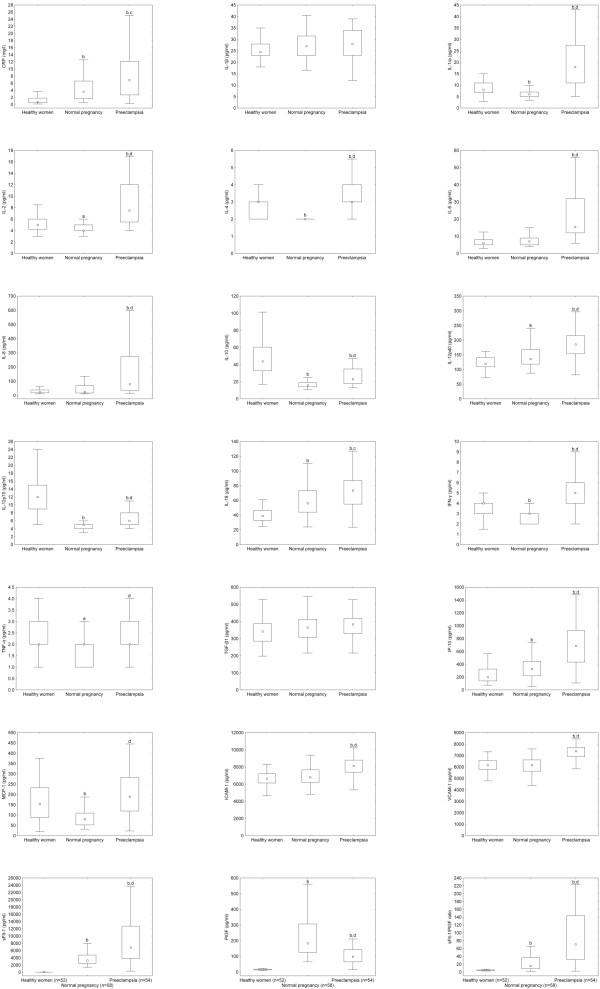
Serum levels of C-reactive protein, cytokines, chemokines, adhesion molecules and angiogenic factors in healthy non-pregnant and pregnant women and preeclamptic patients. Middle point: median; Box: interquartile range (25-75 percentile); Whisker: range (excluding outliers). CRP: C-reactive protein; IL: interleukin; IL-1ra: IL-1 receptor antagonist; IFN: interferon; TNF: tumor necrosis factor; TGF: transforming growth factor; IP: interferon-γ-inducible protein; MCP: monocyte chemotactic protein; ICAM: intercellular adhesion molecule; VCAM: vascular cell adhesion molecule; sFlt: soluble fms-like tyrosine kinase; PlGF: placental growth factor. a p < 0.05 versus healthy non-pregnant women; b p < 0.001 versus healthy non-pregnant women; c p < 0.05 preeclamptic patients versus healthy pregnant women; d p < 0.001 preeclamptic patients versus healthy pregnant women.